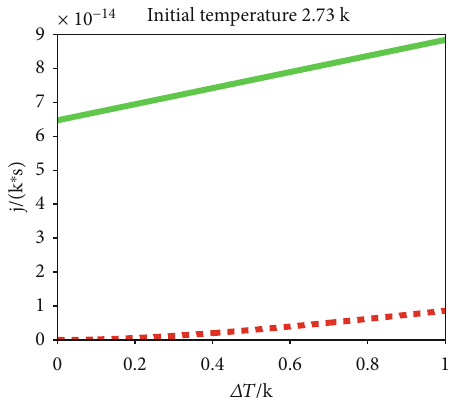
Figure 5: Shows the variation of the irreversible entropy production rate (red line) and the rate of entropy change of black hole (green line) with temperature di ff erence with an initial temperature 2.73k. We fi nd entropy production rate is signi fi cant compared to the rate of entropy change of a black hole at a fi nite temperature; it also holds for other black holes with di ff erent